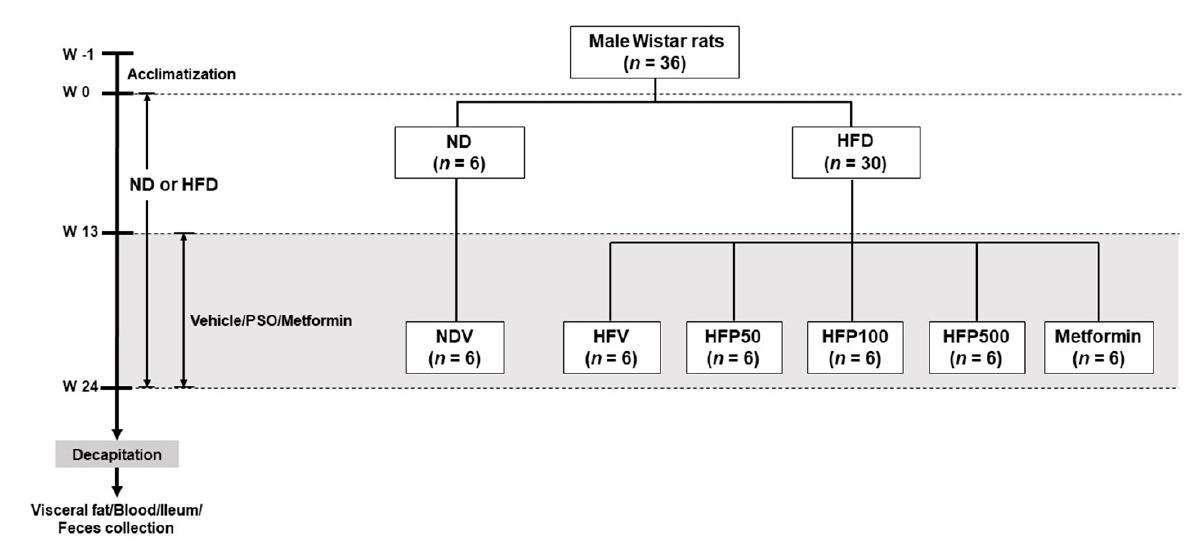
Figure 1. Schematic representation of the animal experimental design in this study. NDV = Normal diet-fed rats treated with the vehicle; HFV = High fat diet-fed rats treated with vehicle; HFP50 = HFD-fed rats treated with 50 mg/kg of PSO; HFP100 = HFD-fed rats treated with 100 mg/kg of PSO; HFP500 = HFD-fed rats treated with 500 mg/kg of PSO; HFM = HFD-fed rats treated with 300 mg/kg of metformin.